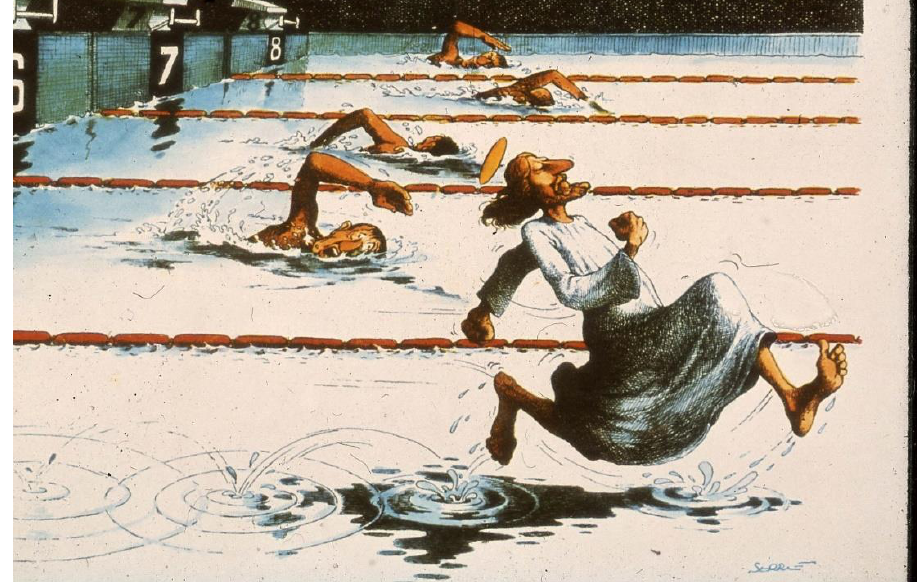
Figure 9. Change in mindset according to Serré [21].